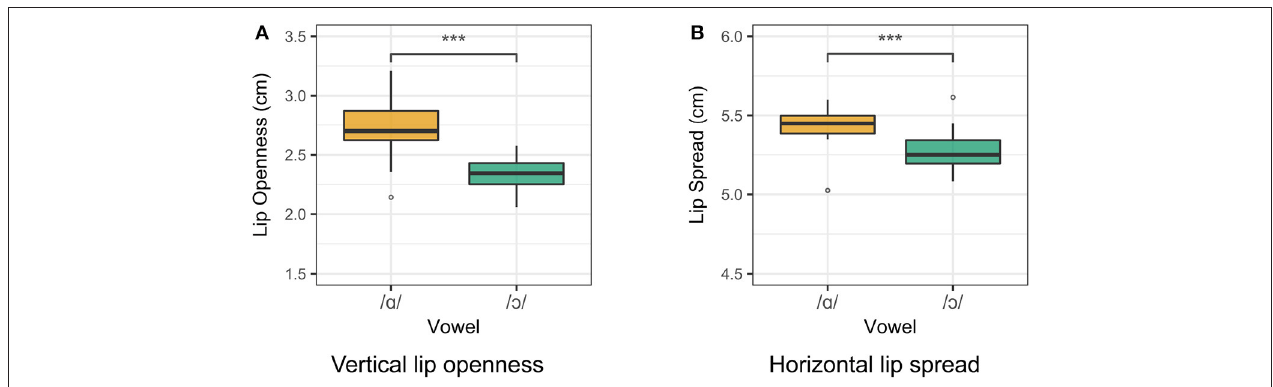
FIGURE 4 | Lip measurements for Speaker 1. Smaller measurements indicate a greater degree of lip rounding. (A) Vertical lip openness. (B) Horizontal lip spread.